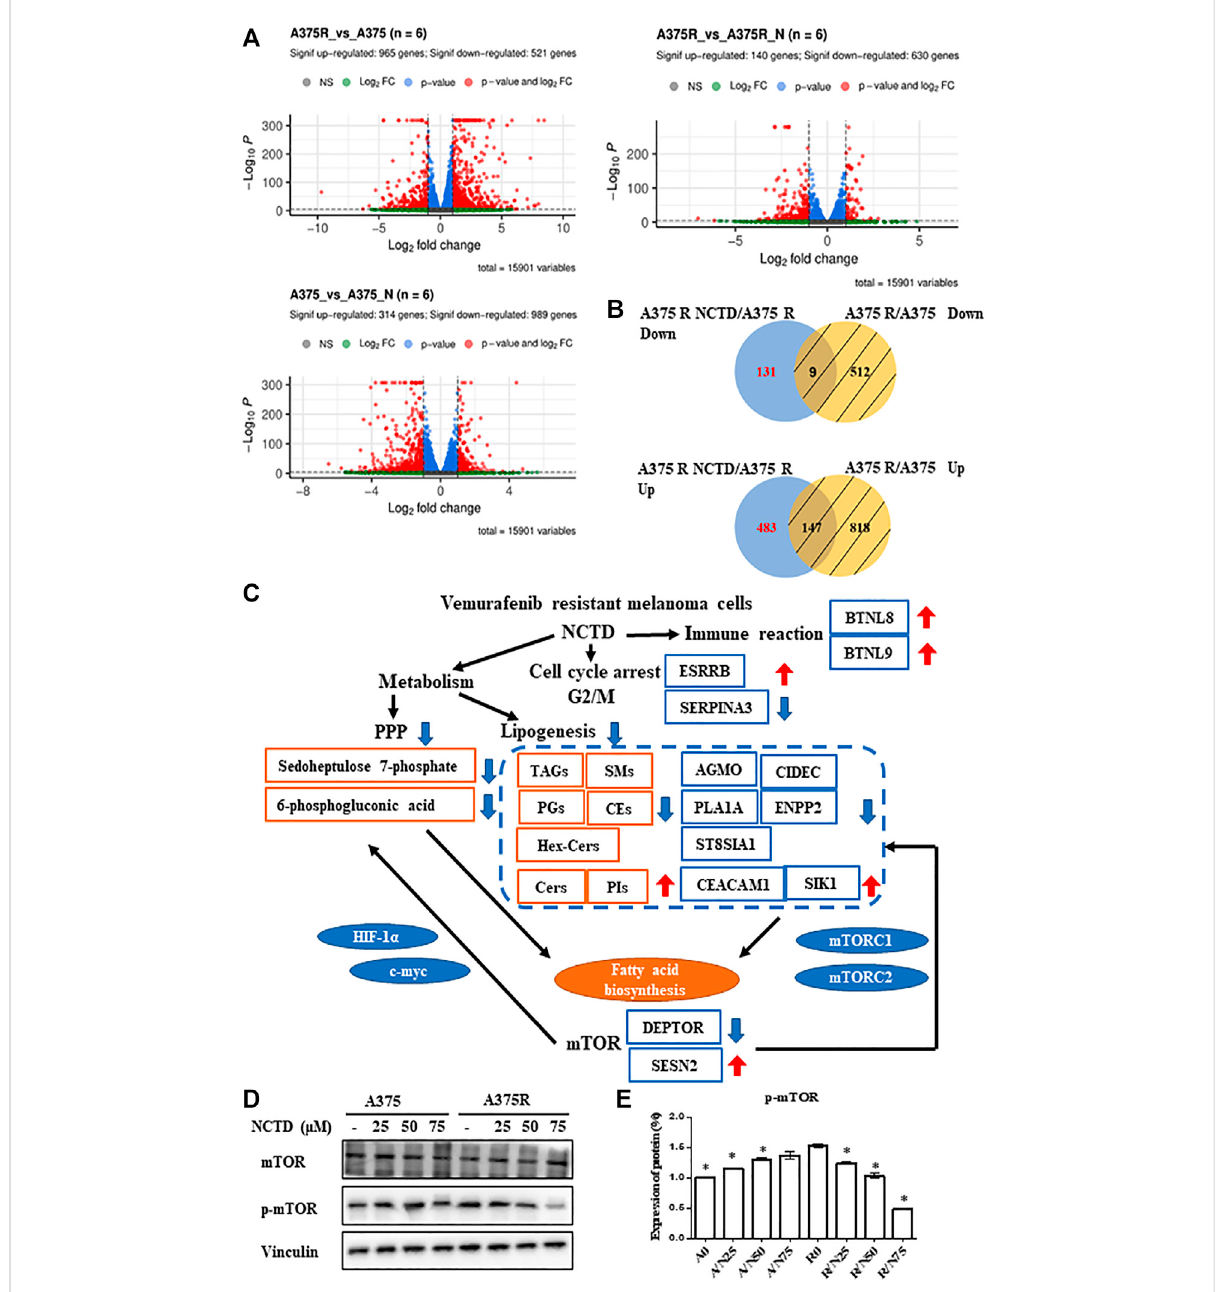
FIGURE 6 Integratedtranscriptomicsandlipidomicsnetworkanalysis. (A) VolcanoplotofdifferentiallyexpressedgenesinA375RversusA375,A375versus A375 + NCTD, and A375R versus A375 + NCTD groups. (B) Intersection of many sets of genes revealed, especially inhibiting and upregulating genes of NCTD in A375R cells. (C) Differential correlation of metabolites, lipids, and genes. (D) A375 and A375R cells after being treated with